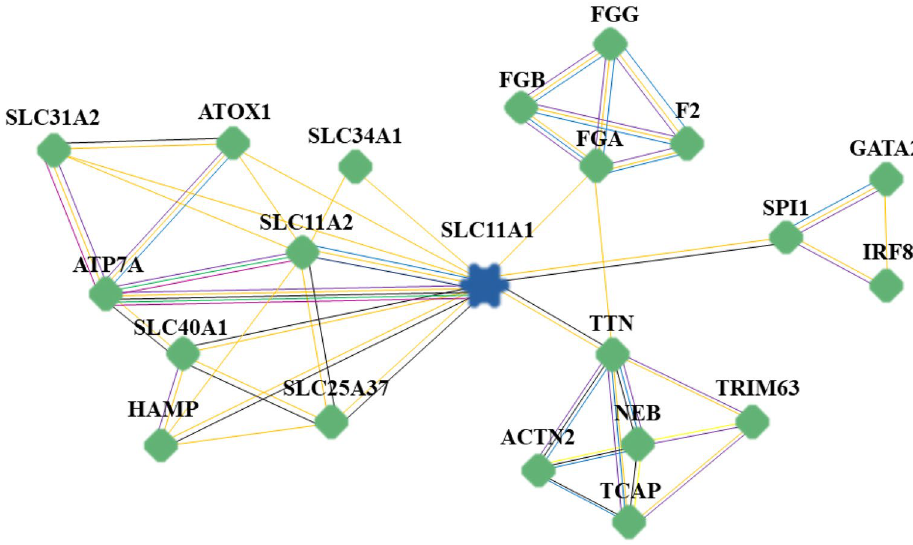
Figure 5. The PPI network of the SLC11A1 protein. Colored lines between proteins indicate evidence of various types of interactions. Regarding “Known Interactions”, the blue lines represents interactions based on curated databases and the purple lines highlight interactions based on experimentally determined. Regarding “Predicted Interactions”, the green lines show interactions based on gene neighborhood; the red lines indicate gene fusions; and the dark blue, represents gene co-occurrence. Regarding “Others,” the yellow lines represents interaction based on text mining; the black lines show co-expression; and the light blue lines represent